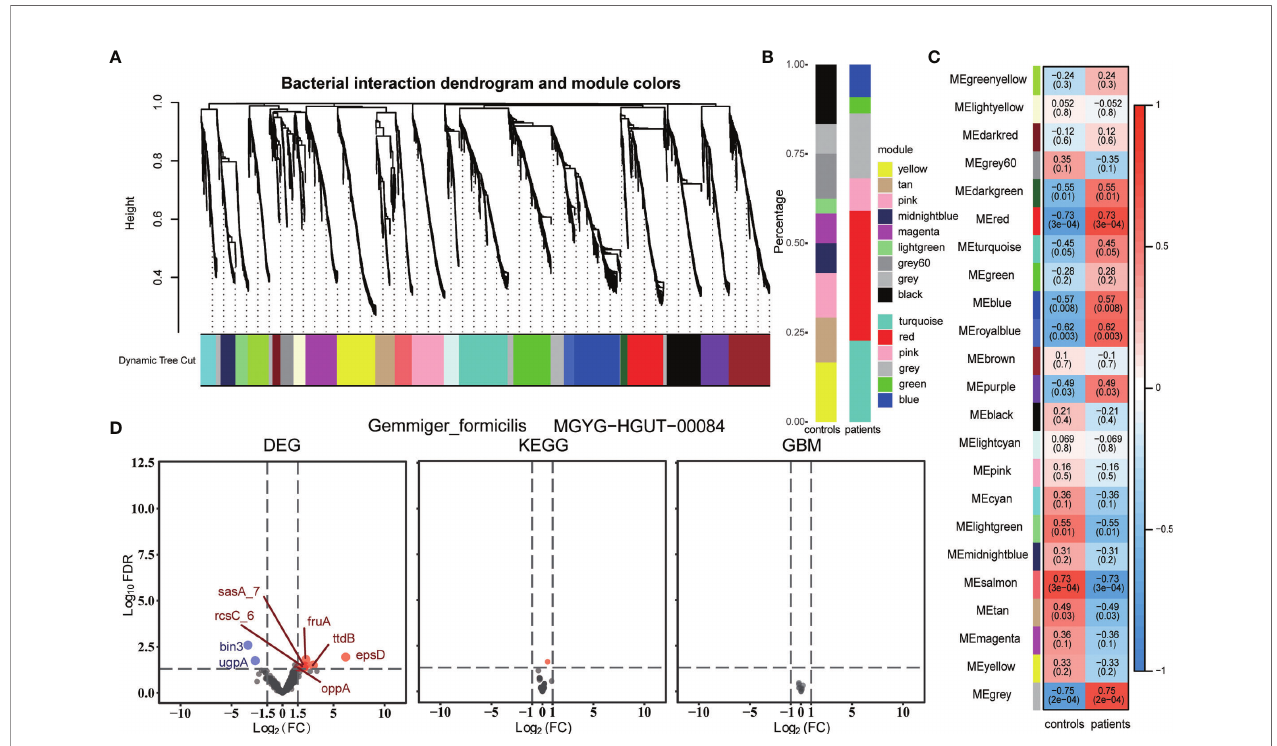
FIGURE 4 | (A) Bacteria interaction modules identi fi ed by WGCNA. (B) Percentage of each WGCNA module bacteria in the group-speci fi c species. (C) Pearson ’ s correlation between bacterial WGCNA modules and groups. Each cell contains the coef fi cient, from -1 to 1 and the P-value. (D) Volcano plots of DEGs, the KEGG modules, and the GBM modules of one WGCNA module hub bacterium, Gemmiger formicilis . DEGs with FDR < 0.05 and |log2FC| > 1.5 and modules with FDR < 0.05 were identi fi ed as differential genes or modules. The blue and red represent the patient group and the control group, respectively. MGYG-HGUT-00084 is the ID of this species in the UHGG